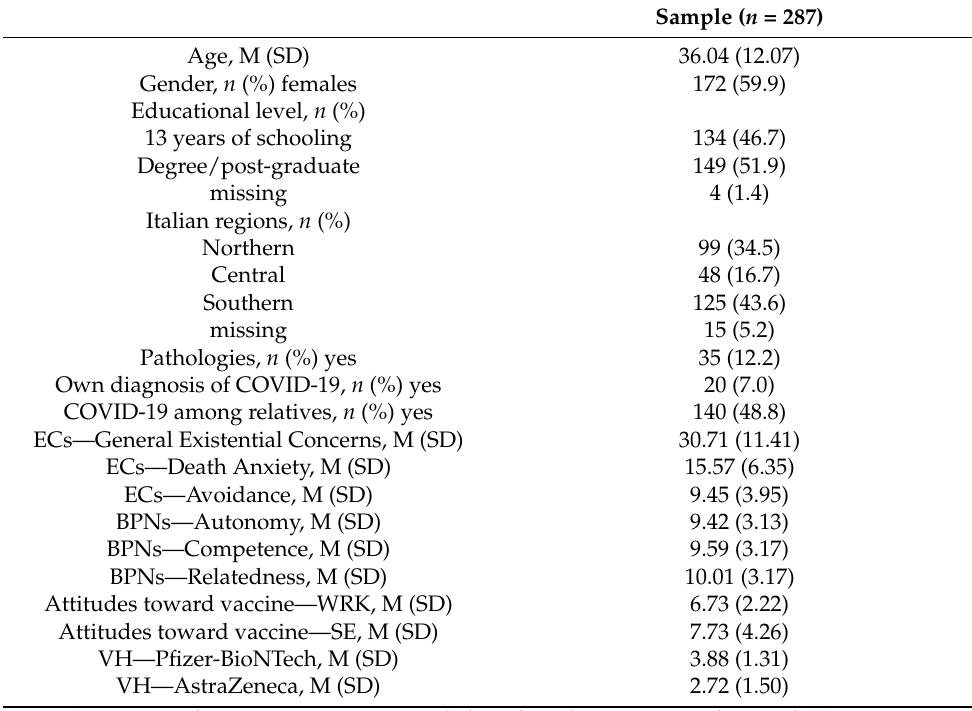
Table 1. Participants’ demographics and health-related data and descriptive statistics for the study